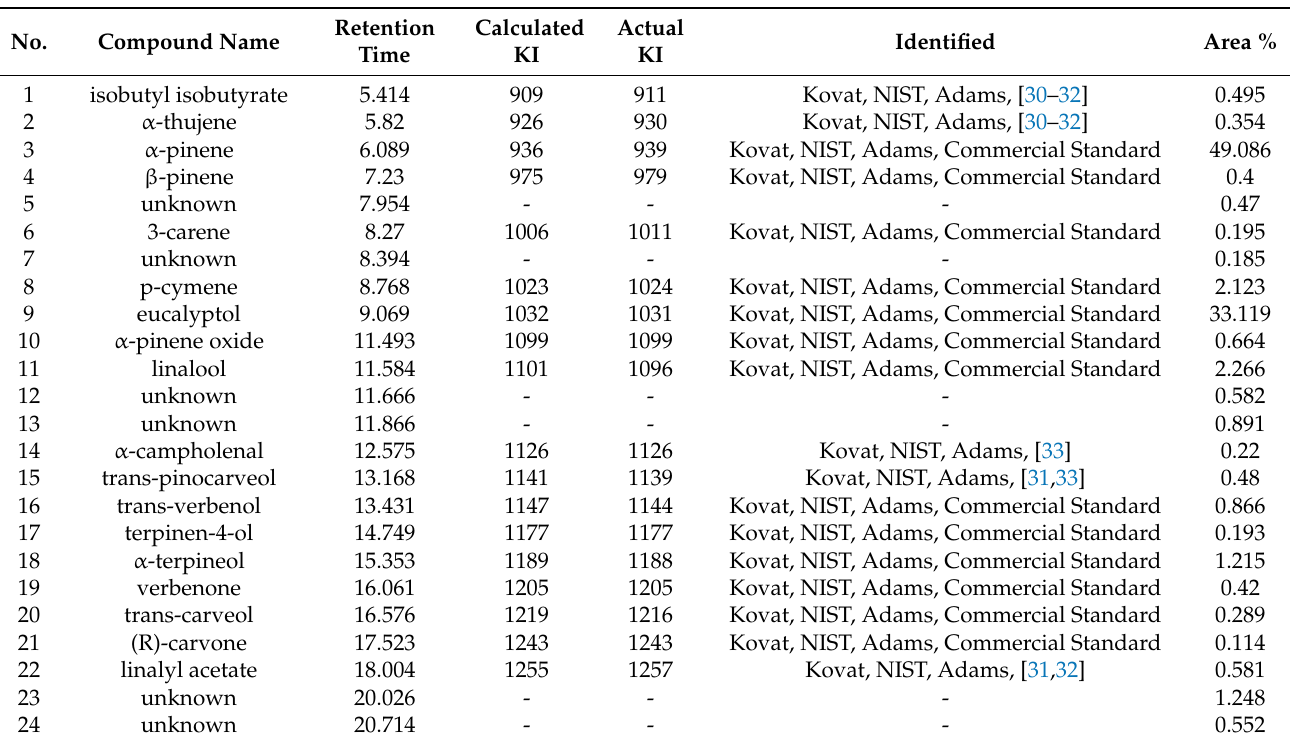
Table 4. Myrtus communis EO constituents identified via GC–MS–FID